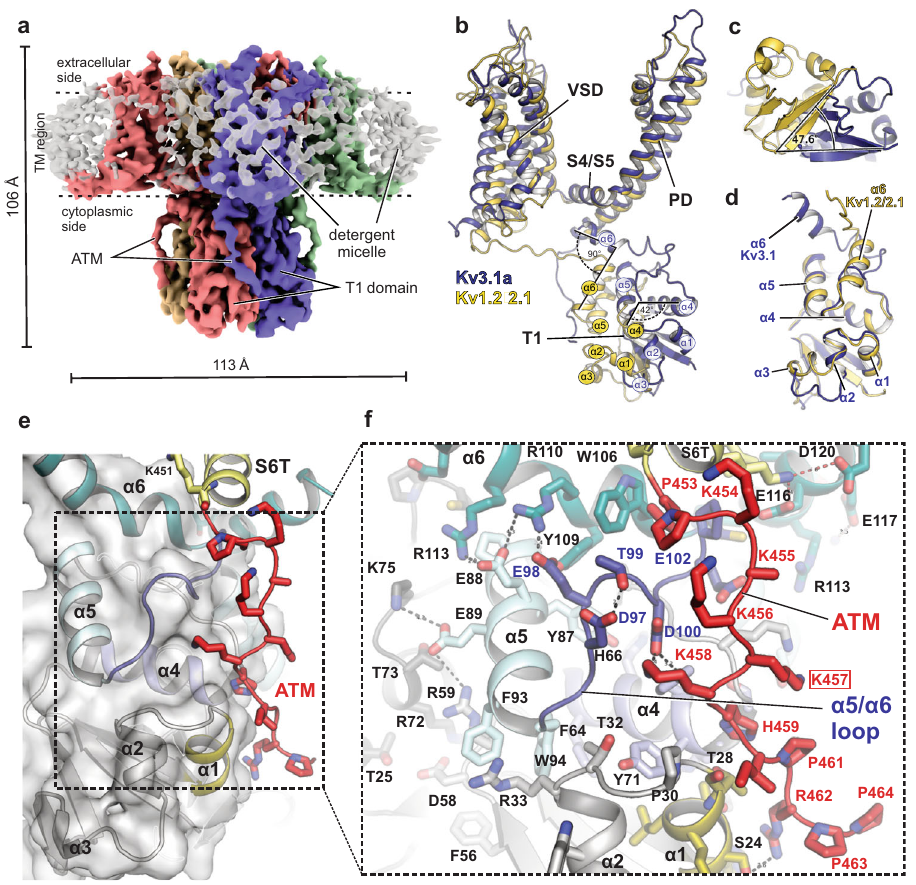
Fig. 1 Kv3.1a full-length structure showing alternative T1 arrangement compared to Kv1.2/2.1 and electrostatic ATM/T1 interactions. a Density maps of the human Kv3.1a channel, coloured by chain. TM region is illustrated by dashed lines. b Superposition of a single chain of Kv3.1a (dark blue cartoon) with one protomer of the Kv1.2-2.1 paddle chimera (pdb: 6EBK, shown in yellow cartoon representation), aligning the S4/S5 linker and pore domain. c Cytoplasmic view of the T1 domain of Kv3.1a superposed on the Kv1.2/2.1 structure (yellow cartoon) using the same alignment as in ( b ). Angle indicates rotational displacement measured between a vector de fi ned by c α atoms of G16/H22 in Kv3.1 and G41/Q47 in Kv1.2-2.1, respectively. d Superposition of an individual T1 protomer (residues 8 – 120, dark blue) from Kv3.1 with the respective region of the Kv1.2-2.1 protomer (yellow). e Detailed view of the ATM/T1 contact region. T1 is shown as semi-transparent surface representation/cartoon and the ATM motif C-terminal from S6T is shown as red cartoon. f Close- up view of the inset from e , illustrating electrostatic contacts between acidic residues in α 5 of the N-terminal T1 domain and a cluster of lysines (K454 – K458) within the ATM of the C-terminus. Red frame indicates location of frameshift variant K457fs associated with EPM7 (ClinVar ID: